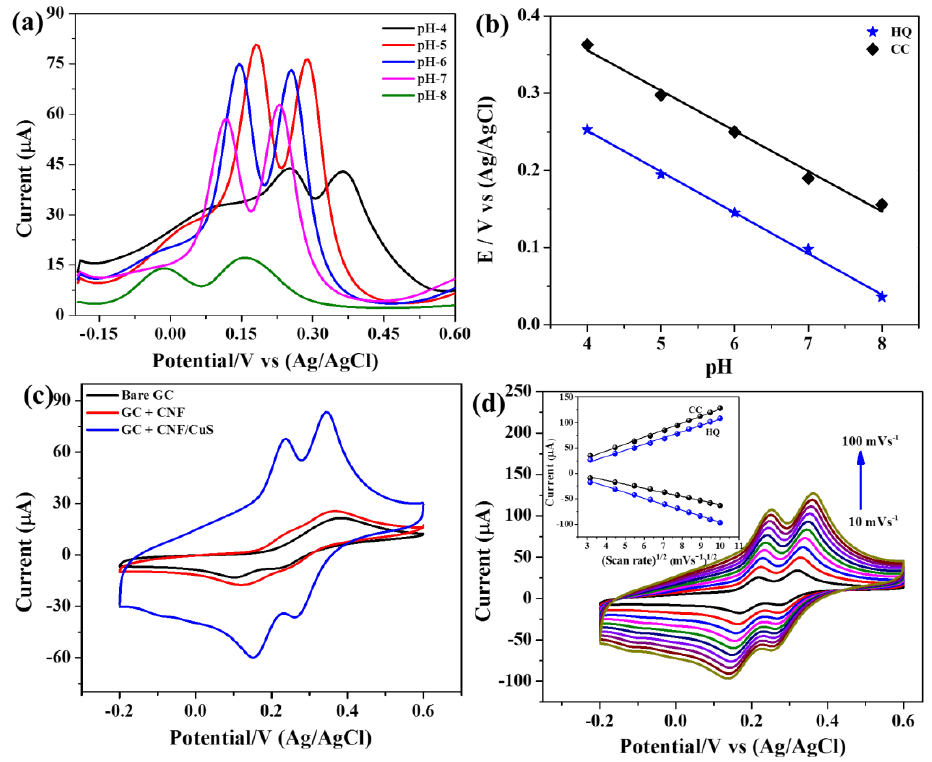
Figure 5. ( a ) DPV curves, ( b ) potential vs pH of CuS-CNF/GCE in 0.1 M PBS containing 50 µM of HQ and CC at different pH value. ( c ) CV curves of different electrodes at 50 mV s − 1 , and ( d ) CV curves of CuS-CNF/GCE in 0.1M PBS (pH = 5) containing a 50 µM of HQ and CC at different scan rates (inset: redox peak potential Vs square root of scan rate).